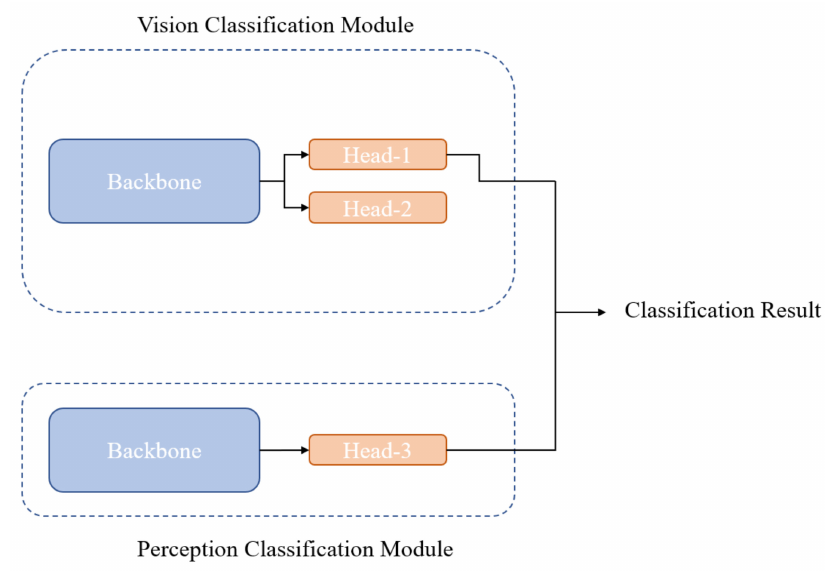
Figure 4. The architecture of the proposed model LLNet (inference phase). The backbone in LLNet is a modified version of the ResNet18, the two layers of which (average pooling, 1000-d fully connected layer) are replaced by an adaptive average pooling layer and a fully connected layer whose dimension is based on the total lane (5 in our experiment because the 1–4 lane indexes cover 99.1% in all condition; 0 lane index represents inability to classify). The head in the vision classification module of LLNet refers to the SoftMax output that corresponds to different labels. A head corresponds to a label that counts the lane index from left to right, whereas another head corresponds to a label that counts the lane index in the opposite direction. The forward propagation in the training phase is shown in Equations